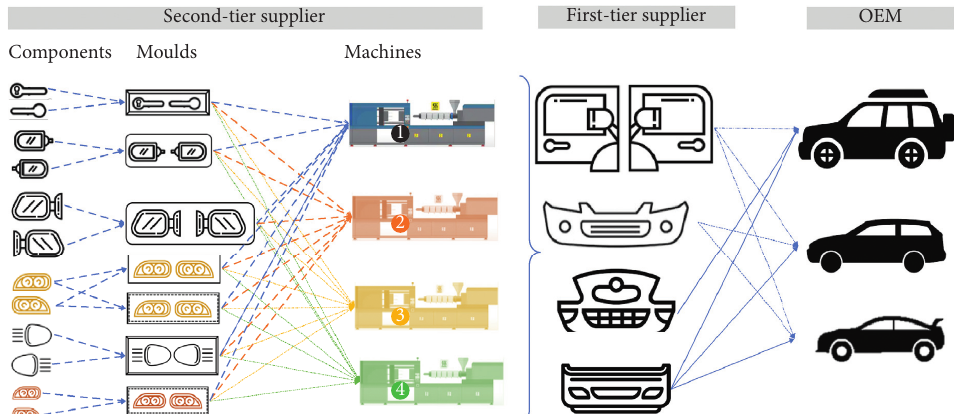
Figure 1: Production scheme on parallel flexible injection machines of plastic components in the automotive supply